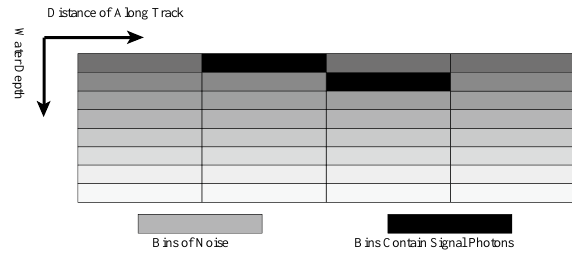
Figure 4. Schematic diagram of underwater photon distribution. The gray bins represent the noise bins, where the greater the noise rate, the darker the color of the grid. The black bins represent the signal bins. As the depth increases, the background noise rate becomes smaller and smaller.